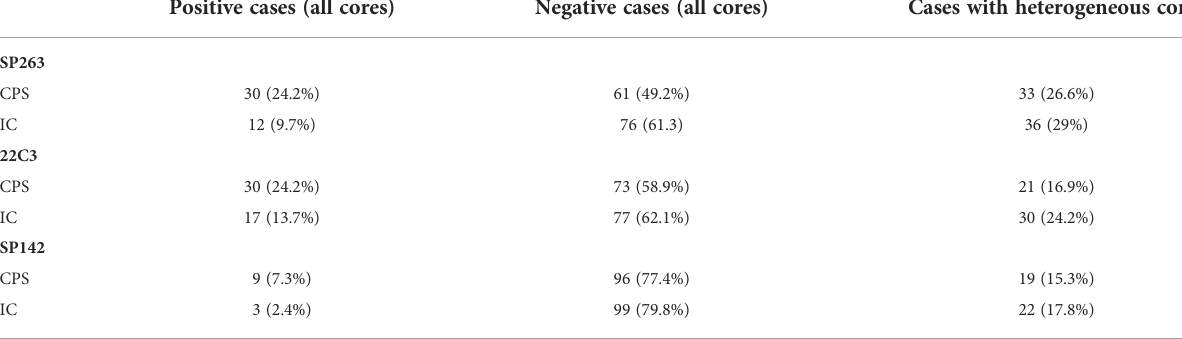
TABLE 5 Staining heterogeneity within tissue cores.